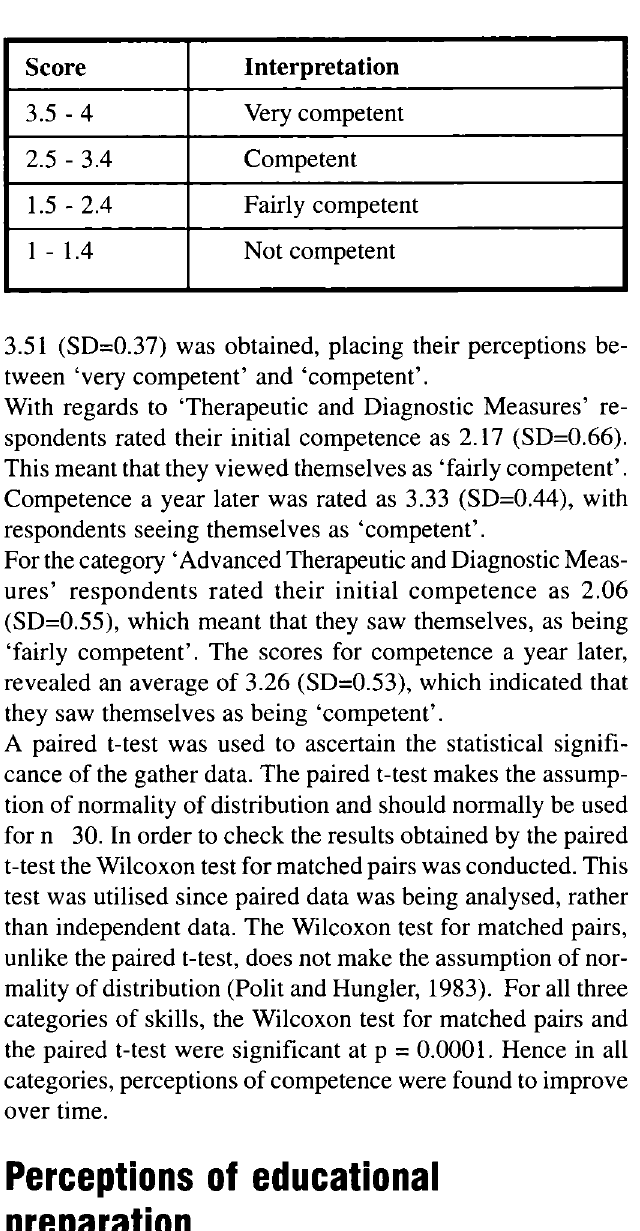
Table 2: Interpretation of the Likert Scale